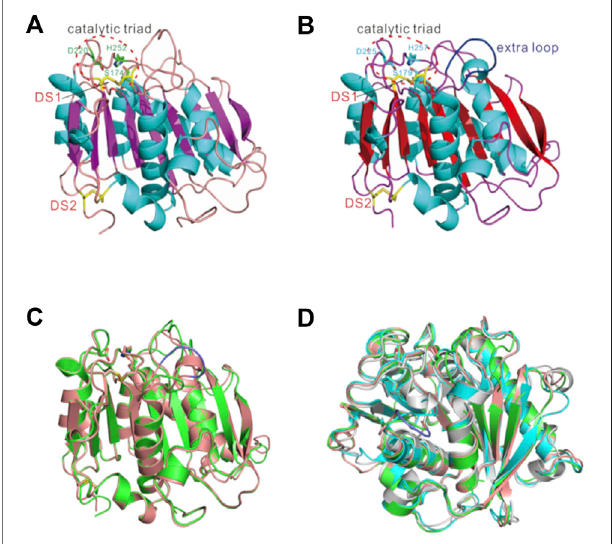
FIGURE 6 | Crystal structures of (A) Ple628, (B) Ple629, superimposed structuresof (C) Ple628(green)andPle629(salmon),and (D) Ple628, Ple629, Is PETase (cyan), and PE-H (gray). The catalytic triads, Ple629 extended loop (blue), and disulphide bonds (labeled DS, yellow) are